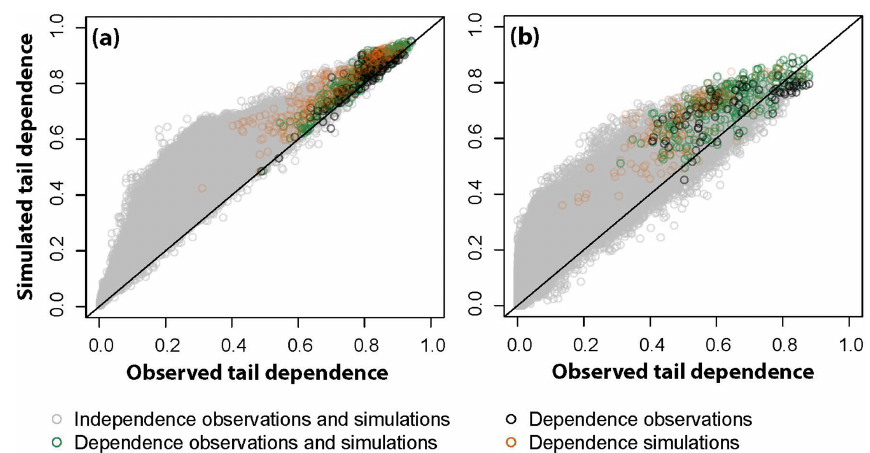
Figure 11. Observed vs. simulated tail dependence coefficient χ for the two thresholds 0.8 (a) and 0.95 (b) . Grey dots indicate pairs of stations with no upper tail dependence, green dots pairs where both observations and simulations indicate upper tail dependence, black dots pairs of stations where only the observations indicate tail dependence, and orange dots pairs of stations where only the simulations indicate tail